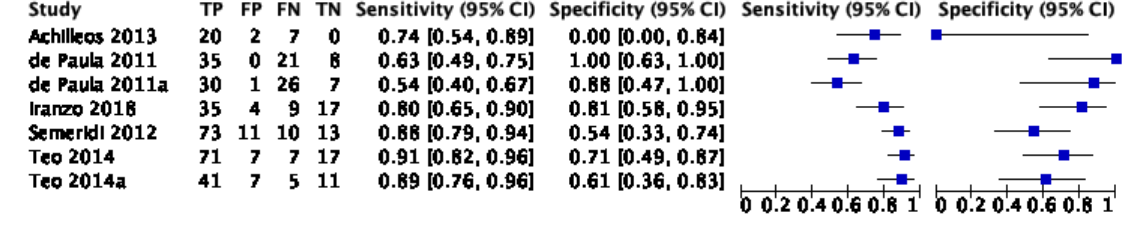
Figure A1. Visual